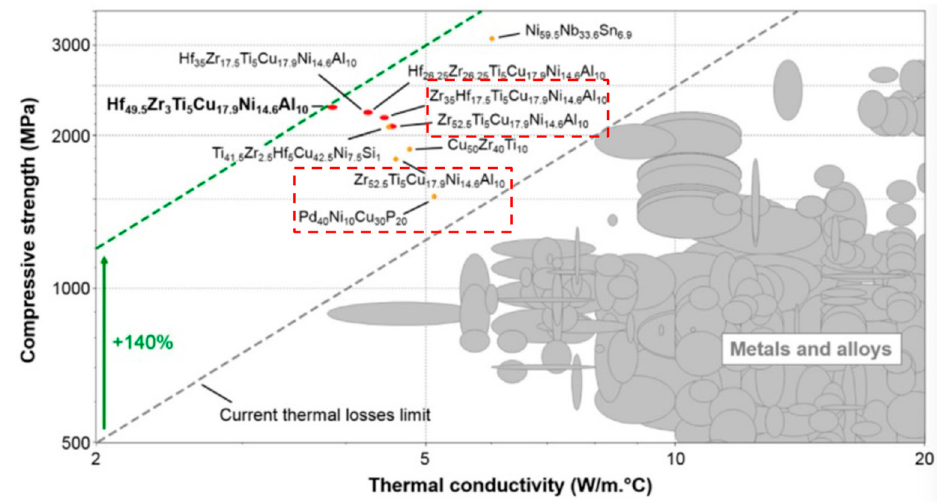
Figure 11. Compressive strength versus room temperature thermal conductivity of metallic glasses, metals, and alloys in Ashby’s material space. Conventional crystalline alloys are shaded while other amorphous alloys are in orange and red, reprinted with permission from Ref. [97] 2018, Elsevier.